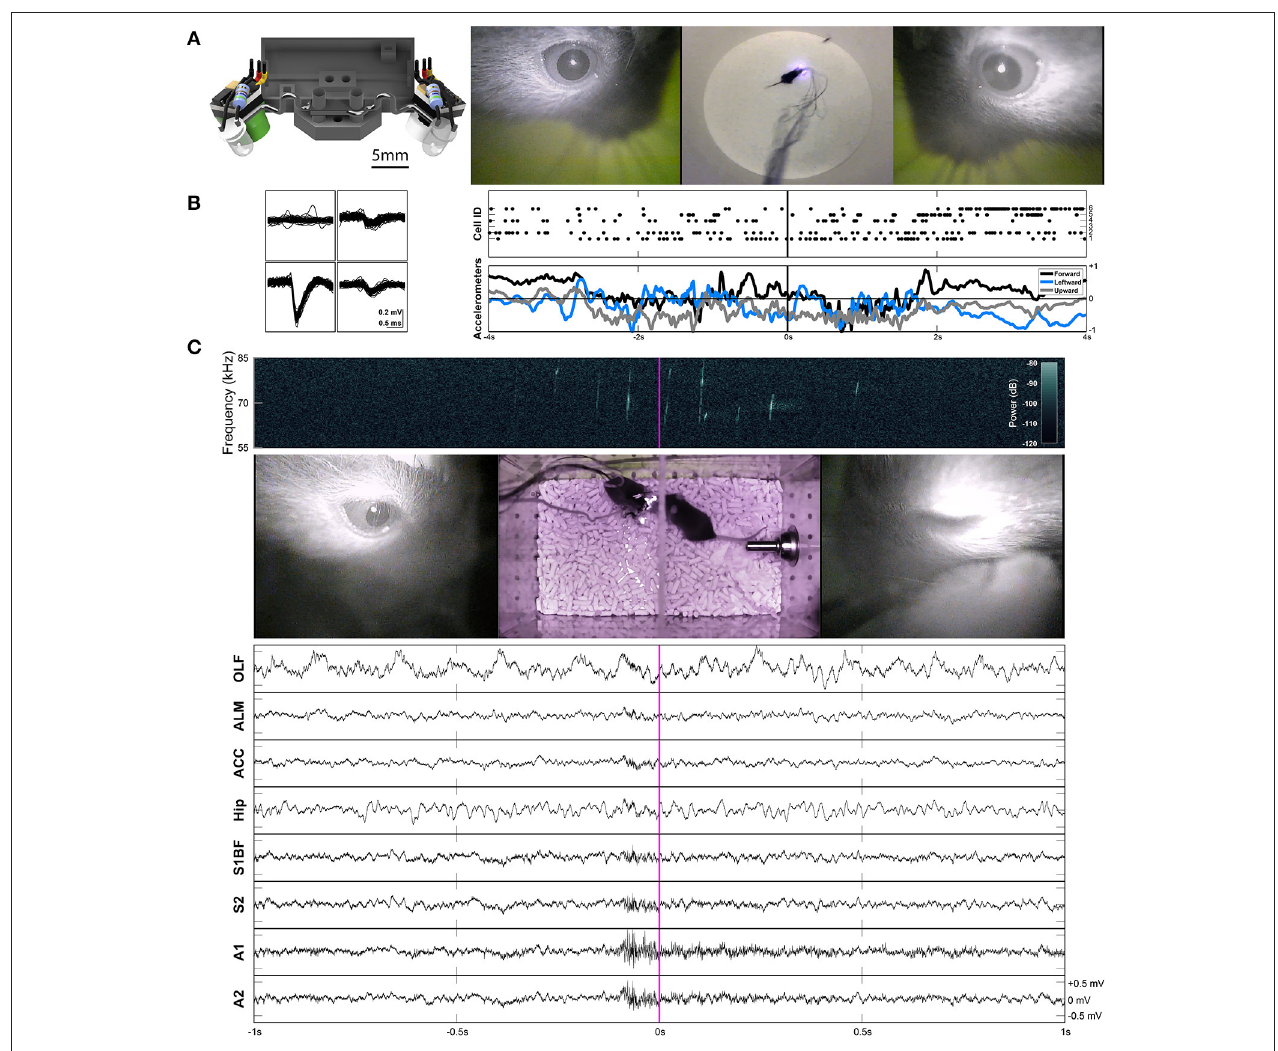
FIGURE 3 | Two-camera headset, and two example applications of freely-moving behavior and electrophysiology. (A) Rendered view of the two-camera headset (left), and an example frame from Supplementary Video 2 showing the signals produced by this headset (right). A collimating lens (revealed on the right side of the render) was used for some experiments, but is not necessary for capturing all eye movements. (B) Example waveforms across the four channels of a tetrode shown for an individual unit (cell ID 1) recorded in anterior lateral motor cortex (ALM) during prey capture behavior. Rasters of cells firing and the accelerometer channels are plotted together (right) for the corresponding frames shown in (A) . The accelerometers are built into the Intan headstage. (C) An example frame from Supplementary Video 3 . The left eye is closed (due to a blink). A spectrogram (top) shows ultrasonic vocalizations occuring during courtship behavior. Continuous LFP traces from various recording locations are shown below. OLF, olfactory bulb; ALM, anterior lateral motor cortex; ACC, anterior cingulate cortex; Hip, CA1 of the hippocampus; S1BF, barrel field of primary somatosensory cortex; S2, secondary somatosensory cortex; A1, primary auditory cortex; A2, secondary auditory